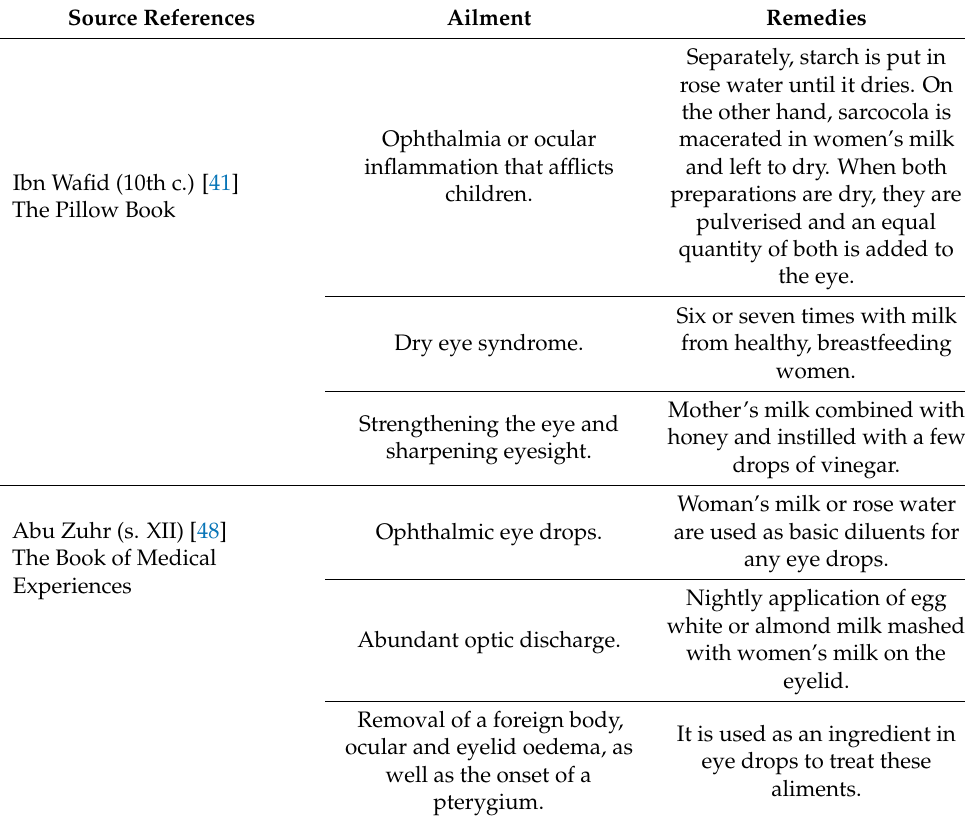
Table 3. Aliments and ophthalmic remedies made from mother’s